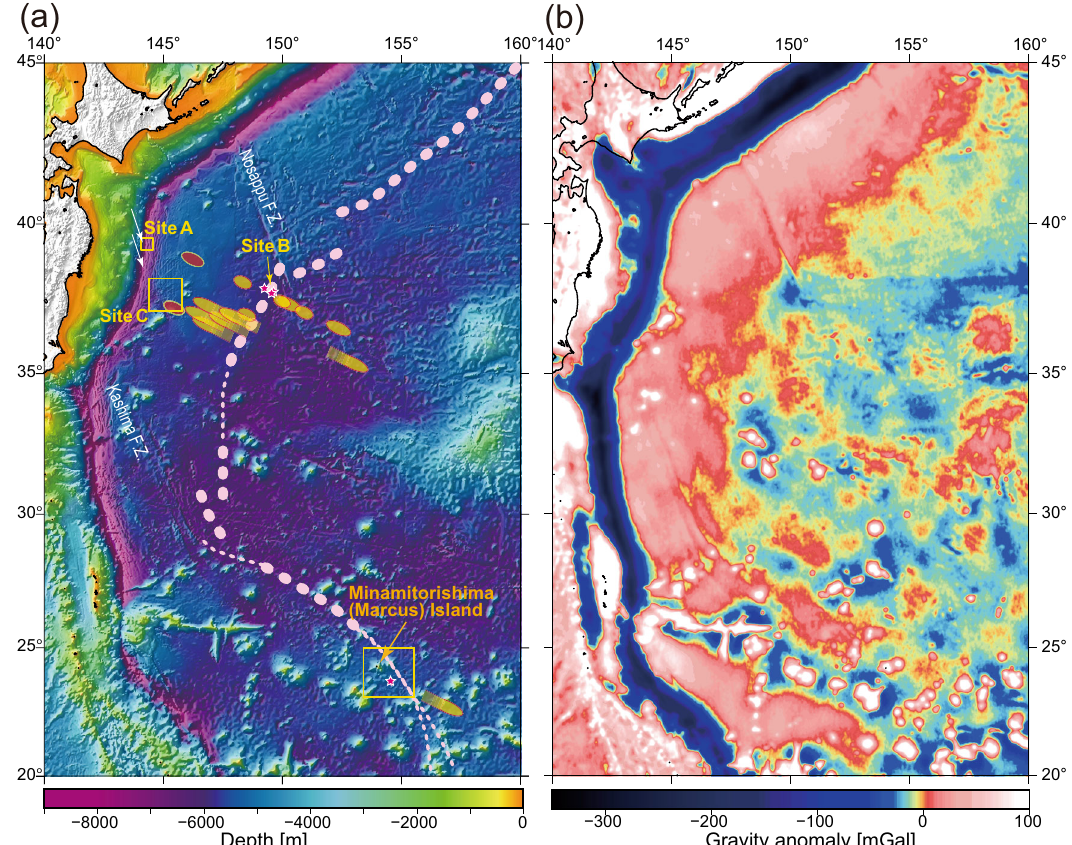
Fig. 1 Bathymetry and marine gravity anomalies of the western part of the Paci fi c Plate. Bathymetry ( a ) and marine gravity anomalies ( b ) are created using the data in ref. 72 . Four petit-spot volcanic fi elds are here referred to as Sites A – C and SE of Minamitorishima Island; yellow squares indicate the areas shown in Fig. 3a, b (Sites A, C) and Fig. 3c (SE of Minamitorishima Island). Red ellipses fi lled with yellow indicate the approximate locations of petit-spot eruption estimated from the eruptive ages of the lavas and assuming constant plate motion at the present-day velocity (10.29 cm yr − 1 ; ref. 73 ) 1,10,14,31,32,41 ; the two yellow ellipses fi lled with red atop the outer rise indicate DAP eruption sites. The thick dotted line in the left panel delineates the present hinge line of the concavely fl exed outer rise of the western Paci fi c Plate trench-subduction systems, as de fi ned by a gravity anomaly of ~0 mGal (right panel). Loading by seamount chains disturbs the positive gravity anomaly of the outer rise, as indicated by thin dotted lines. Small white arrows off NE Japan designate the azimuths of lithospheric structures on the oceanward slope of the trench that are sub-parallel to the neighboring Nosappu and Kashima Fracture Zones ( ‘ F.Z. ’ ) 29